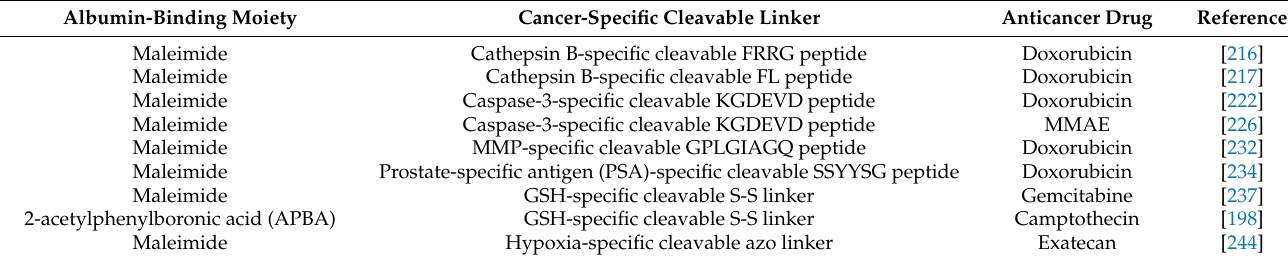
Table 2. Endogenous albumin-binding anticancer